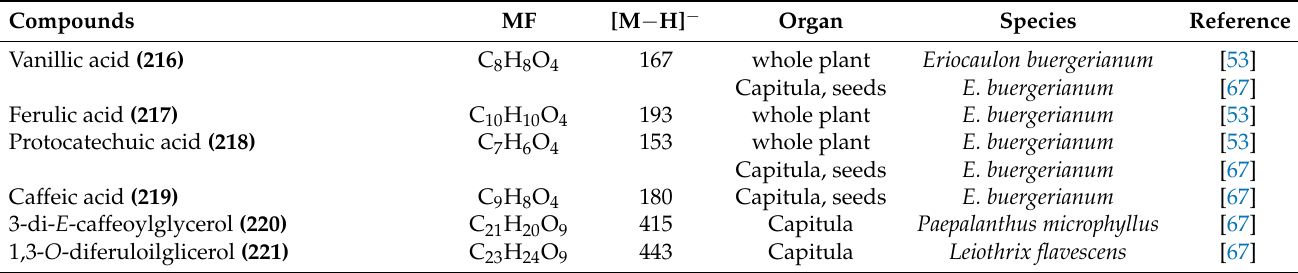
Table 8. Phenolic acids derivatives isolated from Eriocaulaceae species. Compounds